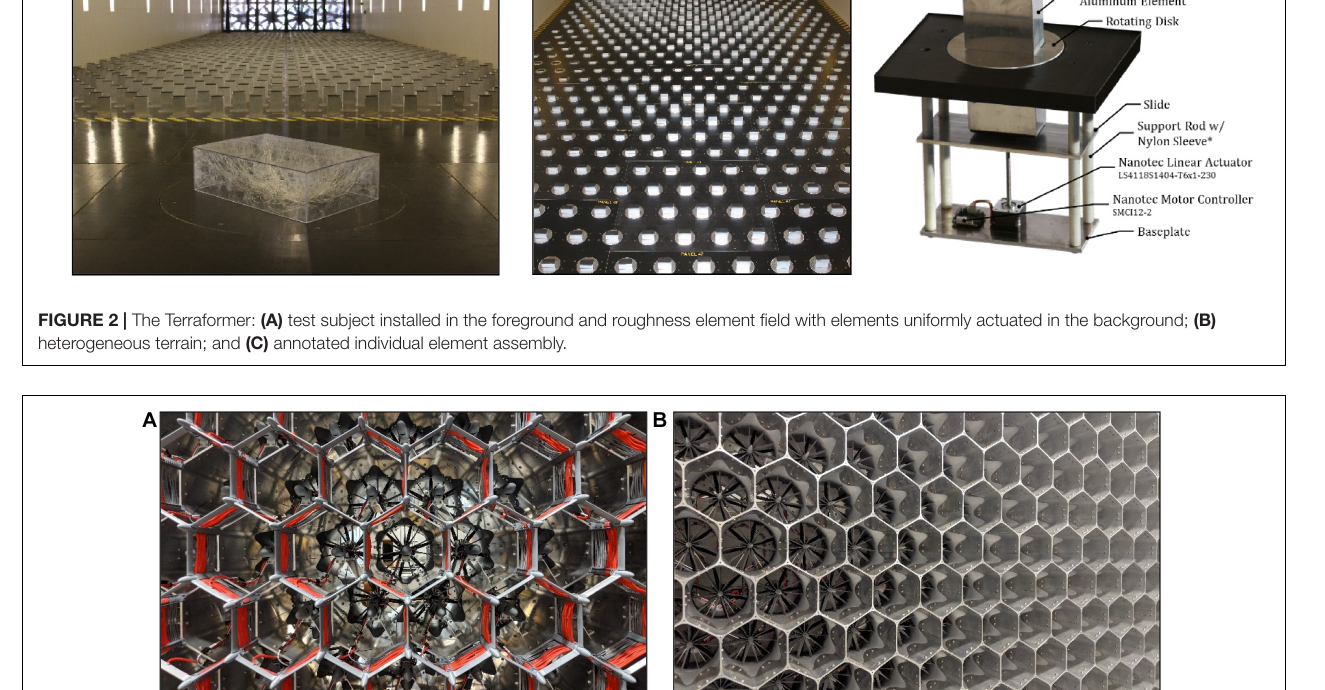
FIGURE 3 | The Flow Field Modulator. Array of 319 modular hexagonal aluminum cells: (A) upwind face; (B) downwind face.